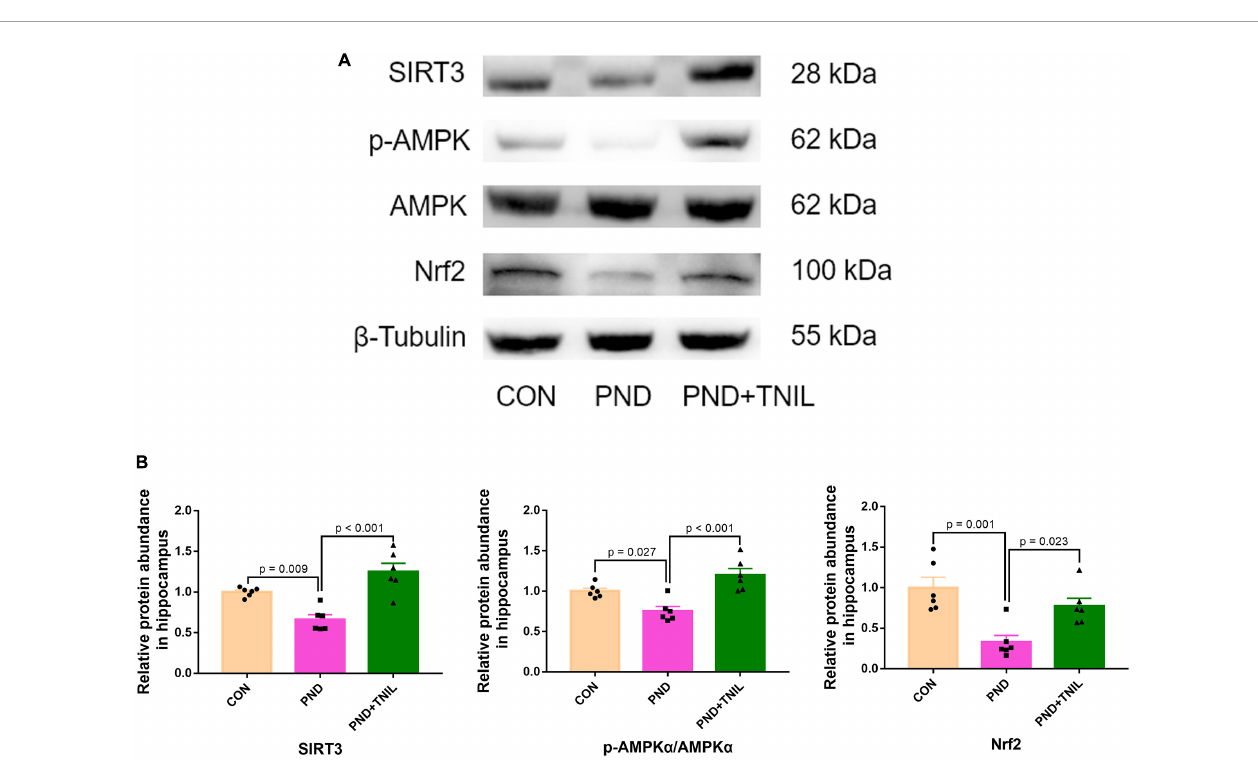
Synapses are the key parts for functional connection and information transmission between neurons (Park and Goda,